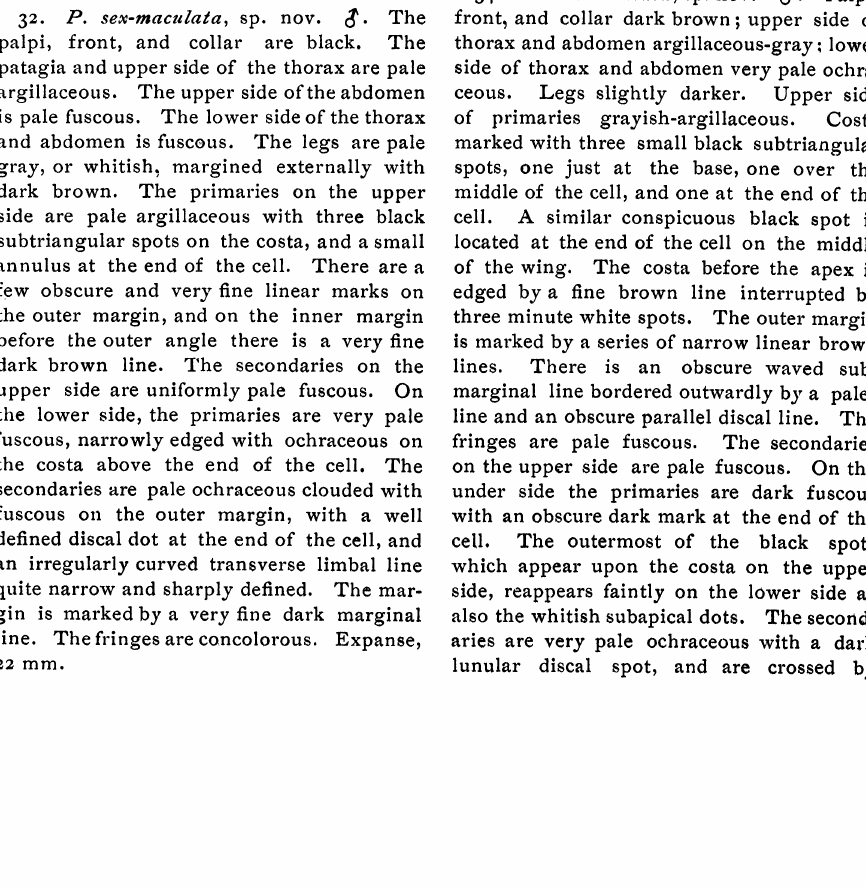
subtriangular spots on the costa, and a small annulus at the end of the cell. There are a few obscure and very fine linear marks on the outer margin, and on the inner margin before the outer angle there is a very fine dark brown line. The secondaries on the upper side are uniformly pale fuscous. On the lower side, the primaries are very pale fuscous, narrowly edged with ochraceous on the costa above the end of the cell. The secondaries are pale ochraceous clouded with fuscous on the outer margin, with a well defined discal dot at the end of the cell, and an irregularly curved transverse limbal line quite narrow and sharply defined. The mar- gin is marked by a very fine dark marginal line. The fringes are concolorous.